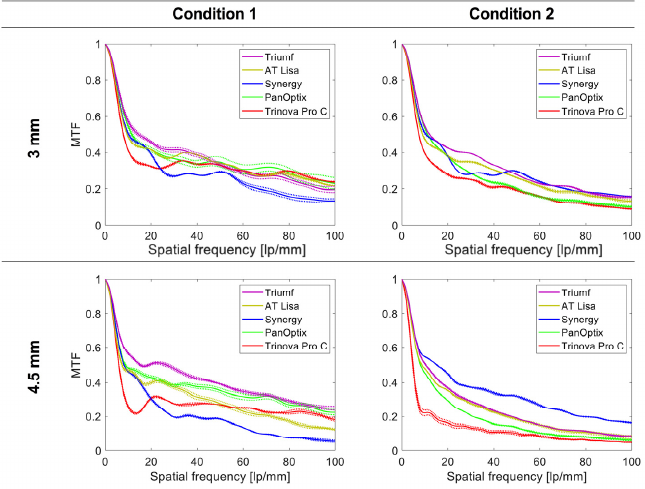
Figure 1. Modulation transfer function (MTF) levels up to 100 lp/mm (equivalent to 30 cyc/deg) of the trifocal intraocular lenses at the far focus for 3- and 4.5-mm pupils. Monochromatic light with an aberration-neutral corneal model was applied in Condition 1, and polychromatic light with a population level of corneal spherical aberration in Condition 2. The dotted lines show the values of each lens separately; the solid lines refer to the average of two samples.